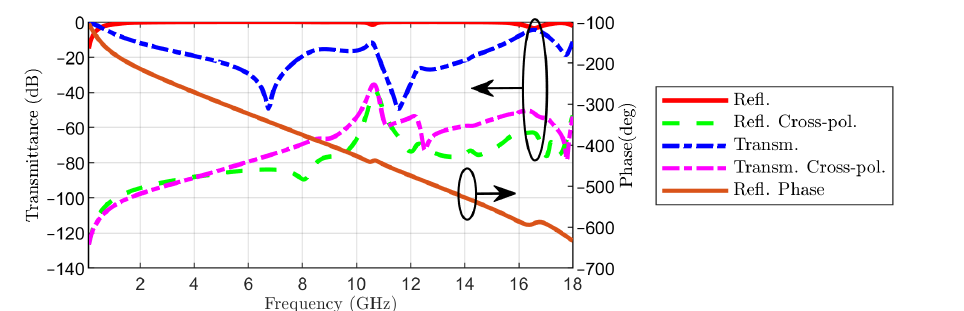
Figure 5. Reflection and transmission coefficients in co- and cross-polarization and phase of reflection coefficient in co-polarization, when the linearly polarized wave is incident from Face 1 of the